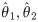
Rejection regions for traditional closed testing.Plot of rejection regions for tests under the traditional closed testing procedure. The omnibus two degree-of-freedom test of H0,12: θ1 = θ2 = 0 will reject the null hypothesis at level α for values (θ^1,θ^2) outside the circle. If the omnibus test is significant at level α, the test of H0,1: θ1 = 0 then rejects outside of the green bar, and that of H0,2: θ2 = 0 rejects outside of the red bar. Note the four small near-triangles in which the omnibus test is rejected but neither test of the two elementary tests is significant.